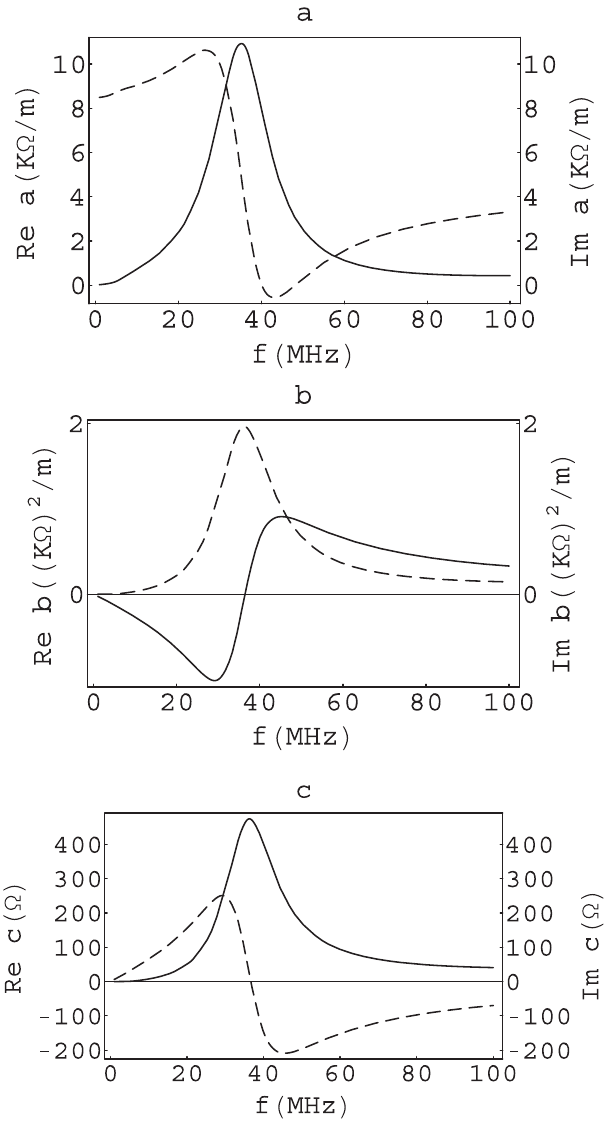
FIG. 5. Real (solid line) and imaginary (dashed line) parts of the parameters a (cid:1) ! (cid:2) , b (cid:1) ! (cid:2) , and c (cid:1) ! (cid:2) vs frequency.